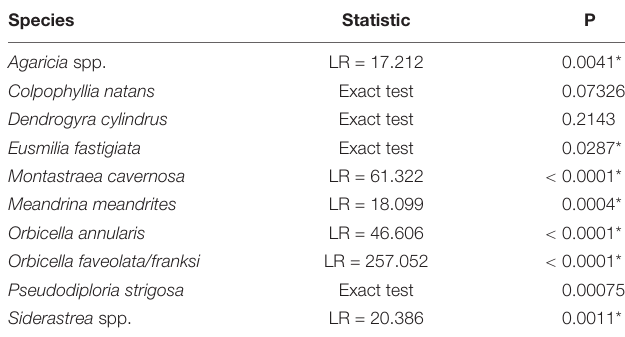
TABLE 2 | Results of analysis of frequencies tests of diseased versus not disease colonies in time points between 2019 and 2020 and all surveys combined for 2005–2018 at FC.